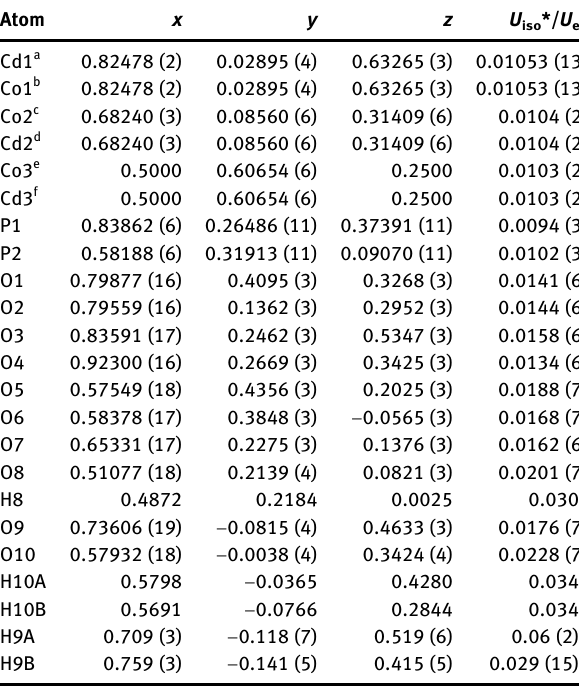
Table  : Fractional atomic coordinates and isotropic or equivalent isotropic displacement parameters (Å 